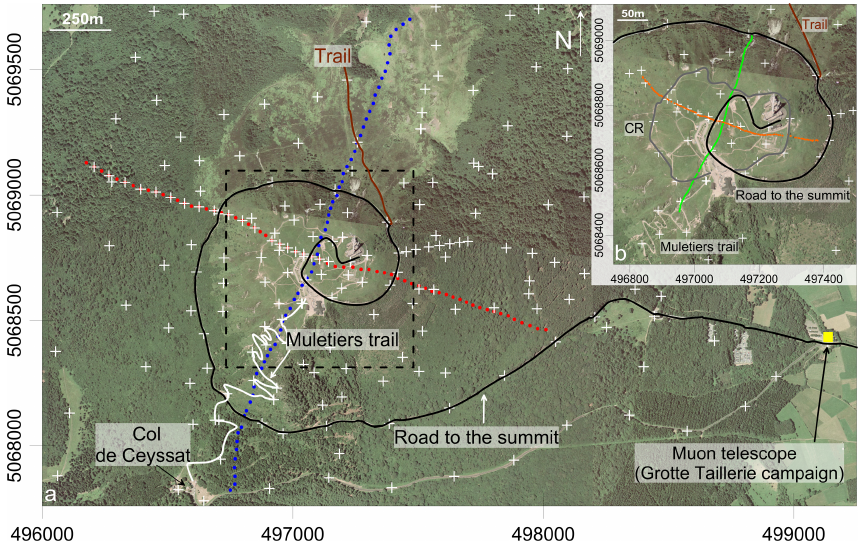
Fig. 2. Location of the ERT lines and gravimetric stations on the Puy de Dˆome volcano (coordinates in meters WGS84, UTM31N). (a) ERT lines in N–S direction (blue dots) and E–W direction (red dots) are composed of 64 electrodes with 35m electrode spacing; (b) ERT lines in the summit area (electrode spacing 5m) in N–S (green dots) and E–W (orange dots) directions. White crosses represent gravity stations. Yellow square refers to muon telescope position during the Grotte Taillerie campaign (January to July